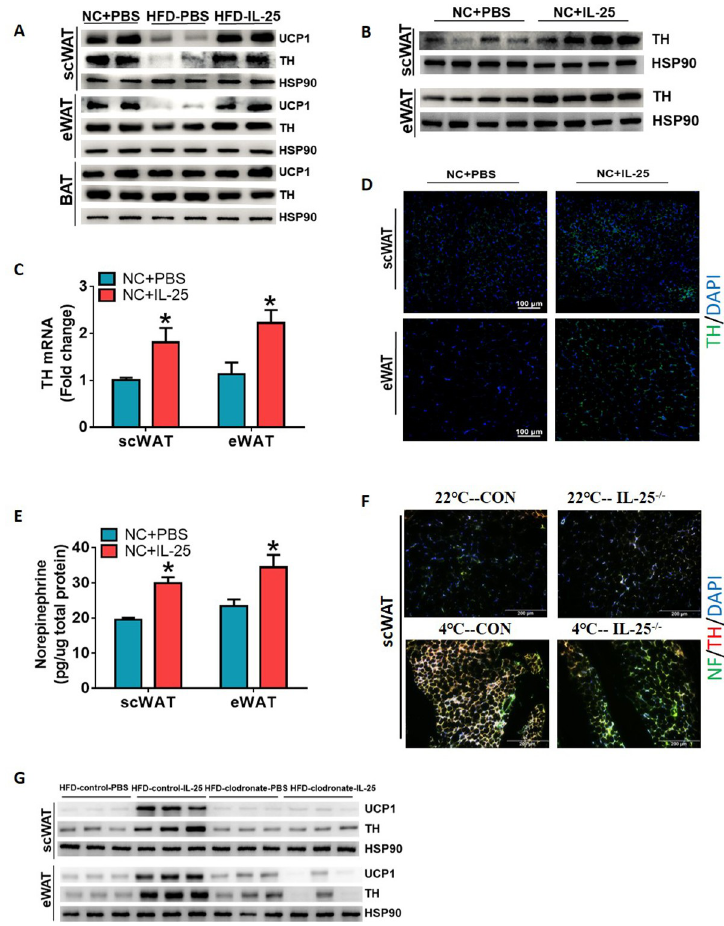
Fig 4. IL-25 regulated the innervation of WAT by macrophages. (A–D) C57/BL6J mice ( n = 5) or mice with DIO ( n = 5) injected with vehicle or IL-25 (1 μ g/day) for 7 days. (A) Western blot analysis for level of TH and UCP1 protein in scWAT, eWAT, and BAT of mice fed with HFD. (B) Western blot analysis of TH protein level and (C) real-time PCR analysis of mRNA level of TH in WAT of mice fed with an NCD. (D) Representative immunofluorescence images of TH in WAT. (E) Total NE production in WAT measured by ELISA. (F) WT mice and IL-25 − / − mice were placed at controlled temperature of 22˚C or 4˚C in individual cages for 5 days ( n = 4–5 per treatment). Representative immunofluorescence images of TH/NF in scWAT. (G) Mice with DIO ( n = 5) injected with clodronate-loaded liposomes to obliterate macrophages and then injected with vehicle or IL-25 (1 μ g/day) for 14 days. Western blot analysis of TH and UCP1 protein in WAT. � p < 0.05 by two-sided unpaired t test. Data present as mean ± SEM. The data underlying this figure can be found in S1 Data. BAT, brown adipose tissue; DIO, diet-induced obesity; eWAT, epididymal WAT; HFD, high-fat diet; IL, interleukin; NCD, normal chow diet; NE, norepinephrine; NF, neurofilament; scWAT, subcutaneous WAT; TH, tyrosine hydroxylase; UCP1, uncoupling protein 1; WAT, white adipose tissue; WT,